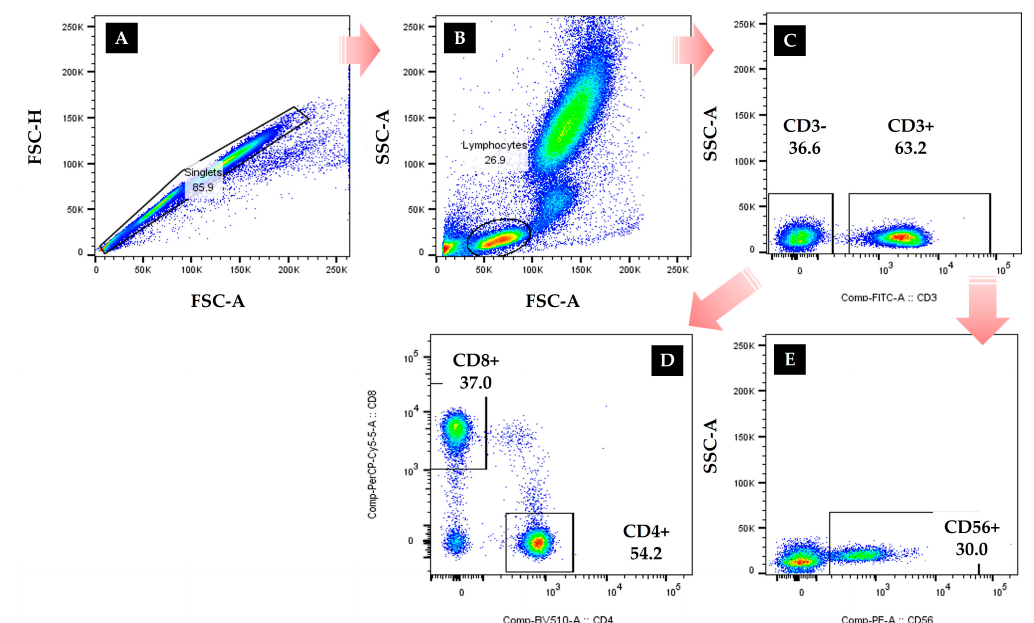
Figure 1. Flow cytometry. Singlet cells were gated by area and height of forward scatter. A front scattered light (FSC)-A and side scattered light (SSC)-A plot was used to identify nucleated cells. (A) Single cells were gated, and doublets were excluded. (B) Lymphocyte gate was set based on the size and granularity of the cells. (C) CD3- and CD3+ were excluded. (D) CD8+ and CD4+ were defined. (E) CD56+ was identified.